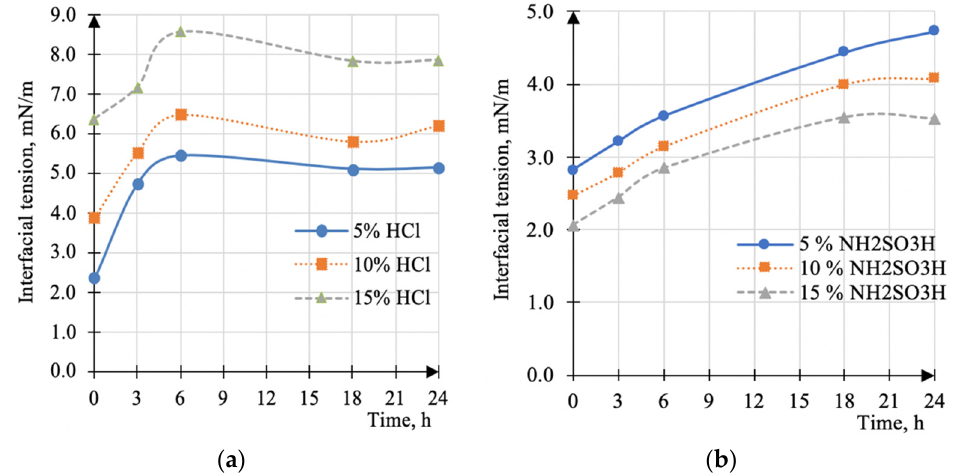
Figure 9. The index of interfacial tension in hydrochloric ( a ) and sulfamic ( b ) acids at the interface with n-octane with the addition of corrosion inhibitor IC-1 (conc. 0.5% wt.) and IC-2 (conc. 0.4% wt.) after corrosion tests in 3, 6, 18, 24 h, respectively.